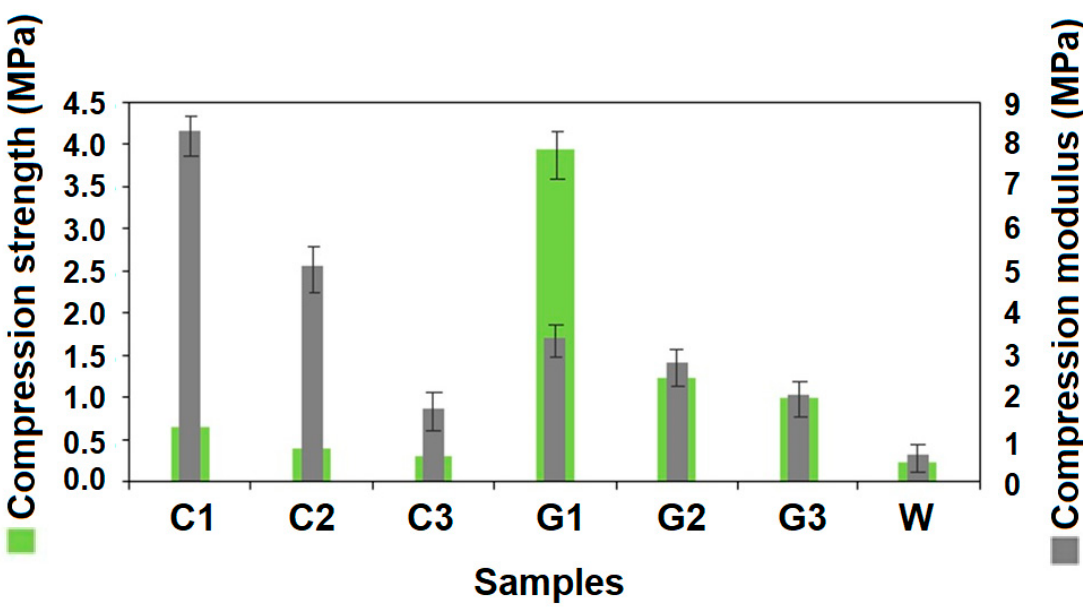
Figure 6. Compression strength and modulus of RC and glass fiber-reinforced hollow composites versus double-layered cardboard.